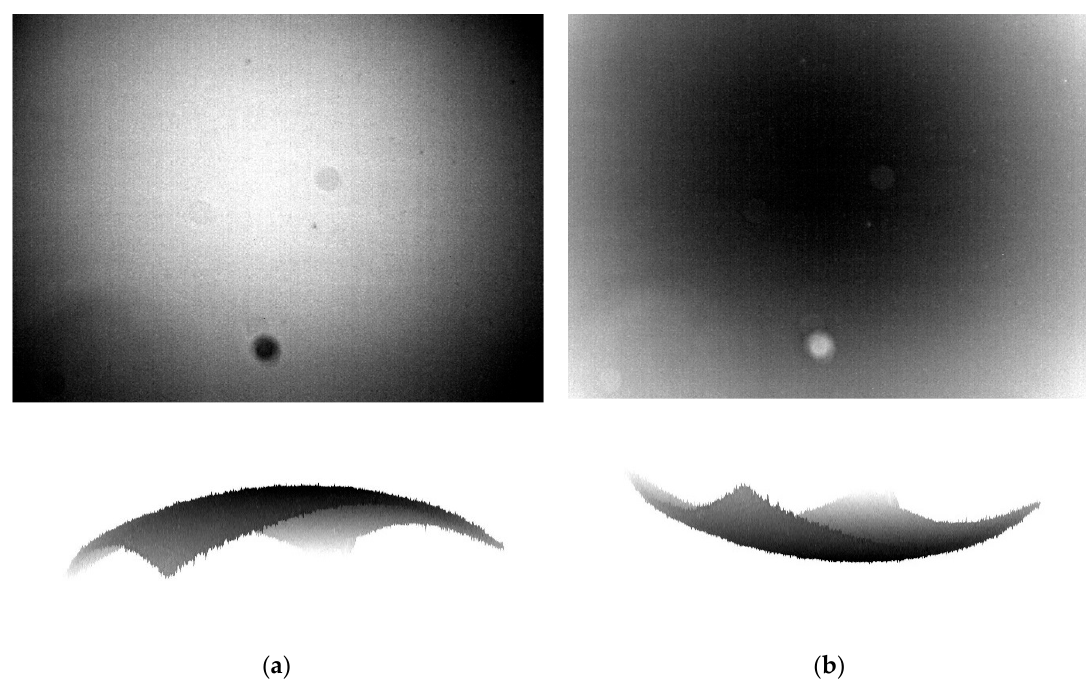
Figure 7. ( a ) 3D Illustration of vignette effect and flat field image with typical light falloff and bumpy surface caused by nonuniform quantum efficiency in Channel 4; ( b ) corresponding correction coefficient image. The black stigma in (a) is the dust on sensor itself that could not be removed by user, but it could be corrected using look-up-table (LUT) correction method (b).